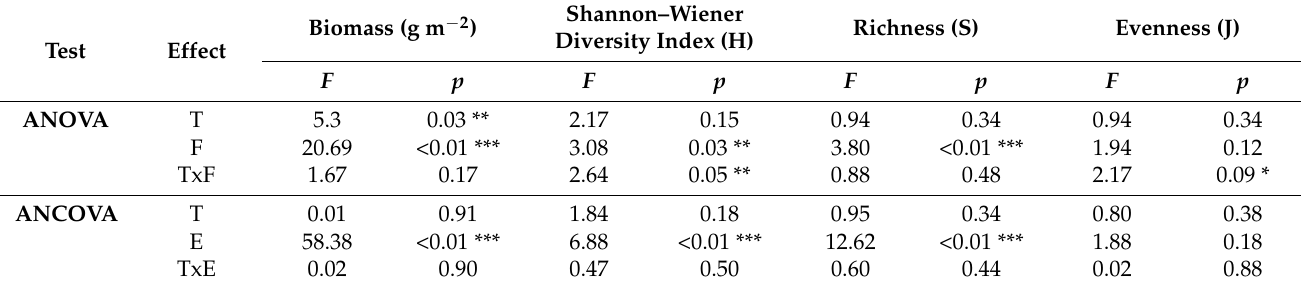
Table 7. Analysis of variance (ANOVA) and analysis of covariance (ANCOVA) results for understory Shannon–Wiener diversity index (H), richness (S) and evenness (J). Results include F -statistic ( F ) and p -values ( p ). ANOVA assessed effects of reclaimed water treatment (T) and facility (F) for the diversity parameters. The ANCOVA assessed the effects of establishment date (E) as a covariate.